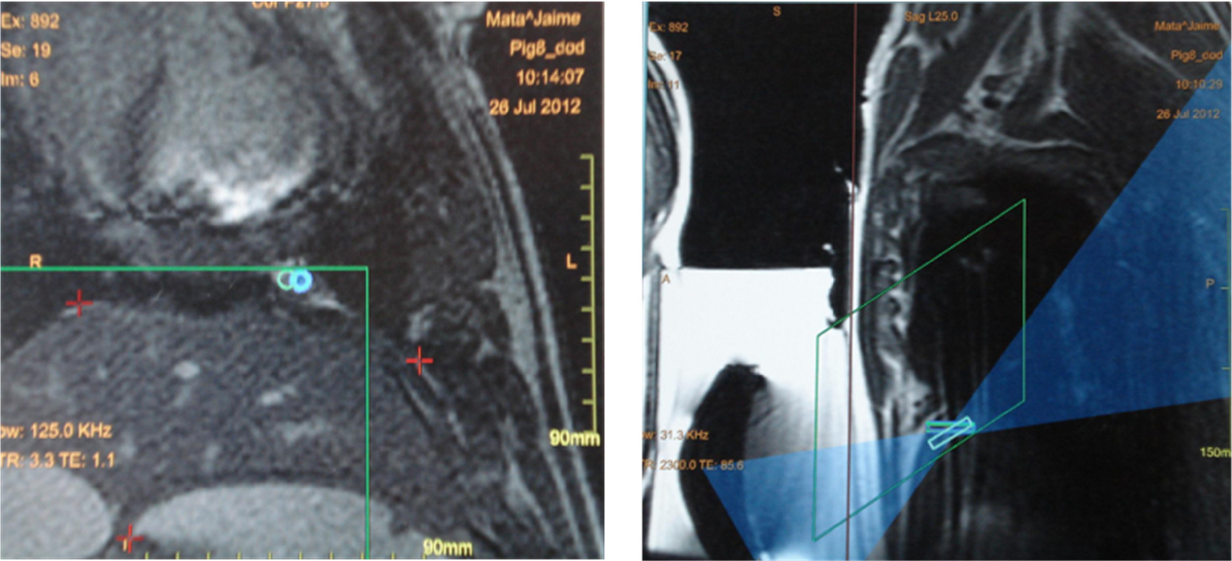
Figure 6. ( Left ) The blue circles in this coronal MRI above the diaphragm represent two focal spots planned, both localized inside the green square which represents the area available for treatment. The red crosses in the middle of the image mark the position of the diaphragm. ( Right ) Sagittal view of the image used for treatment planning. The rectangles represent the depth of the focal spots. The blue region corresponds to the beam path across the adjacent tissue.